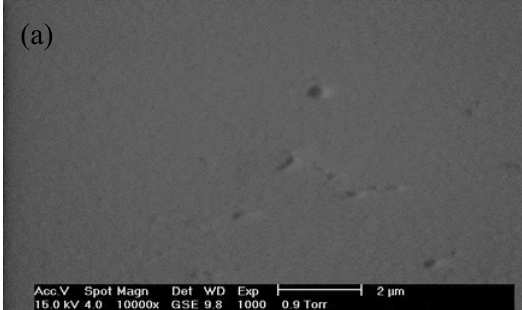
Figure 5. SEM micrograph of the pore content at Lu